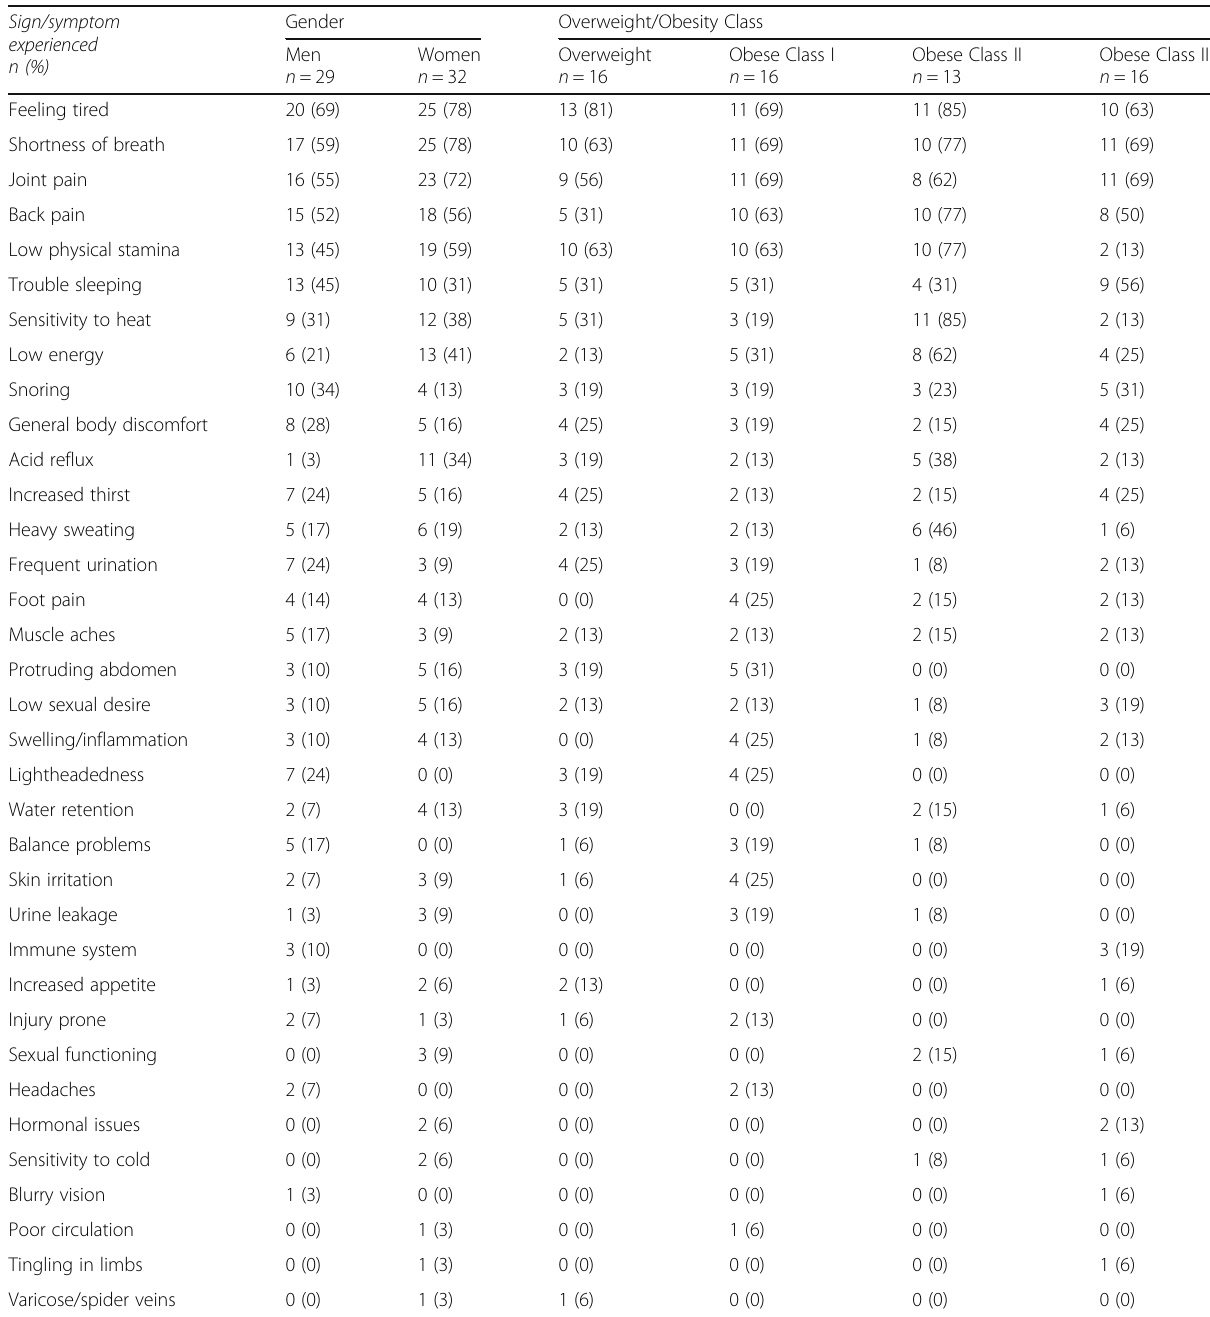
Table 2 Physical signs and symptoms by gender and weight class Sign/symptom